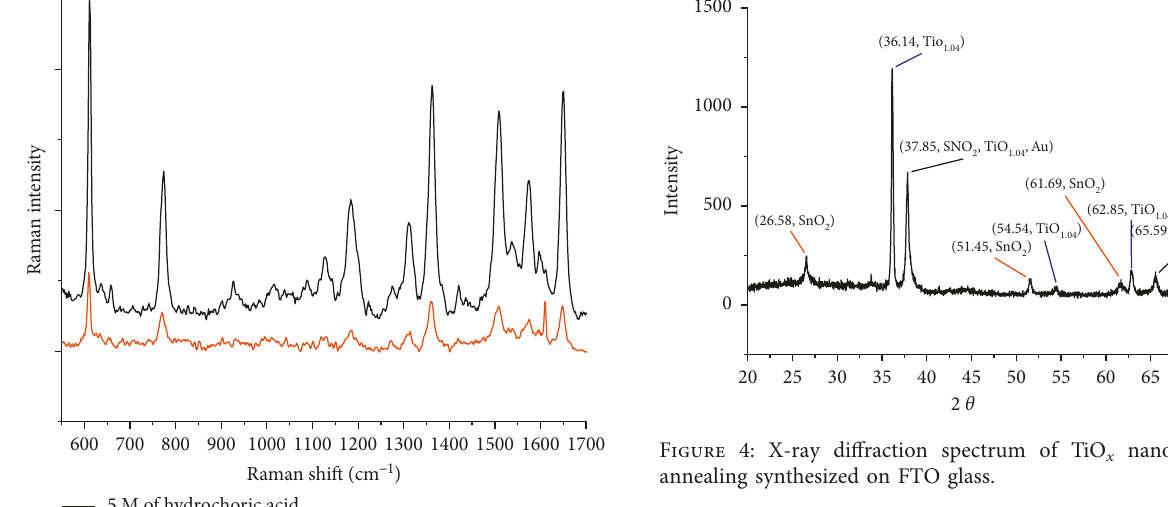
x nanorod after